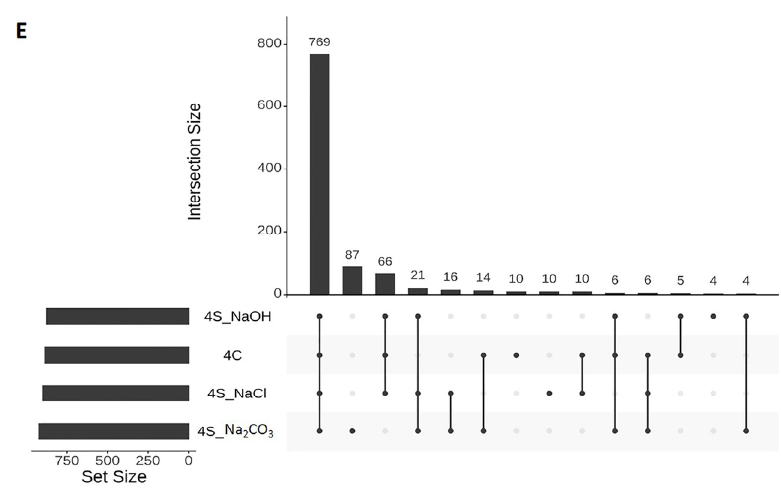
Figure 1. The transcriptomic analysis of root samples in diploid and tetraploid rice under control and NaCl, NaOH, and Na 2 CO 3 stress conditions. ( A ) Heat map hierarchical clustering of global transcription factor (TF) gene expression. Upset plots depict the number of unique and shared TF families ( B , C ) and TF genes ( D , E ) expressed in roots. 2C and 4C represent diploid and tetraploid plants under control conditions, respectively; 2S and 4S represent diploid and tetraploid under three stress conditions, respectively.